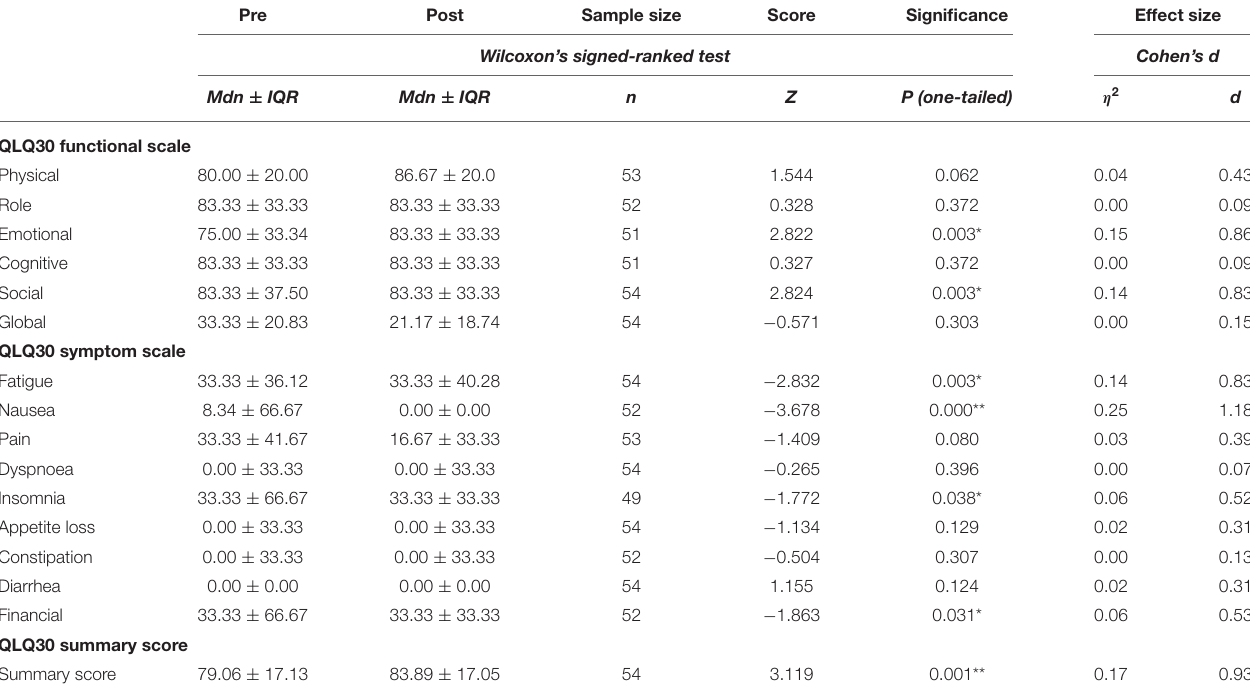
TABLE 3 | EORTC QLQ-C30 (V3) Cancer-Related Quality of Life Questionnaire Pre–post Intervention Comparisons. Pre Post Sample size